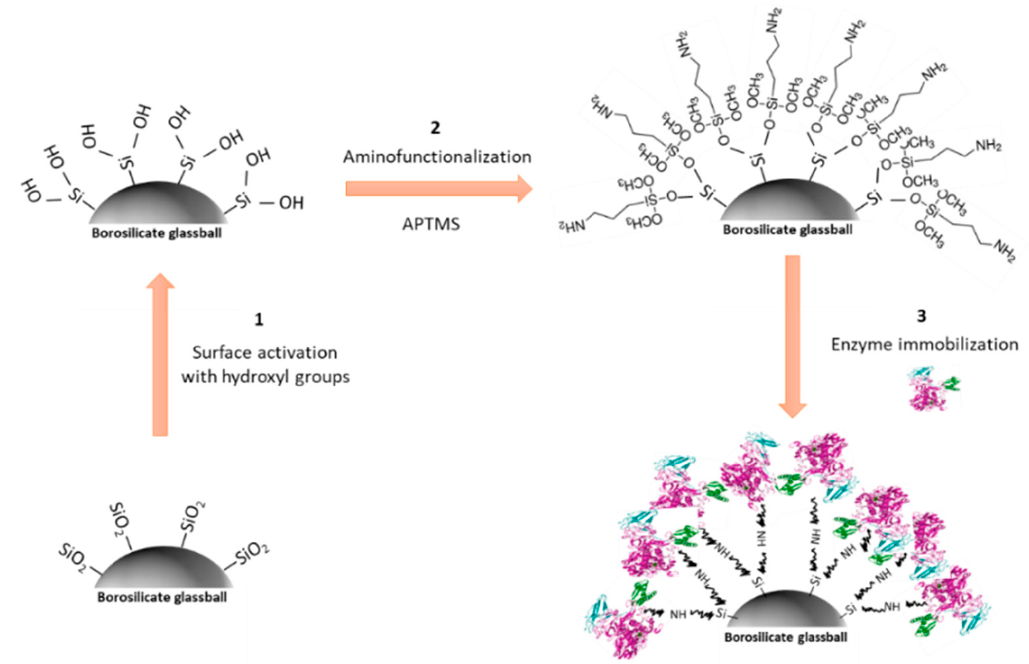
Figure 4. Schematic diagram of covalent urease immobilization on a borosilicate glass surface involving surface functionalization with APTMS.